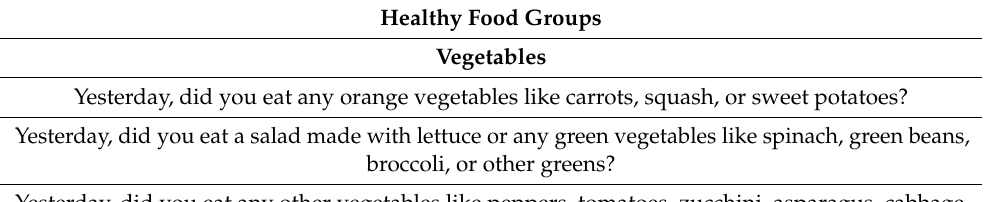
Table 1. School Physical Activity and Nutrition for Mexican American Adults (SPAN MAA). Healthy Food Groups